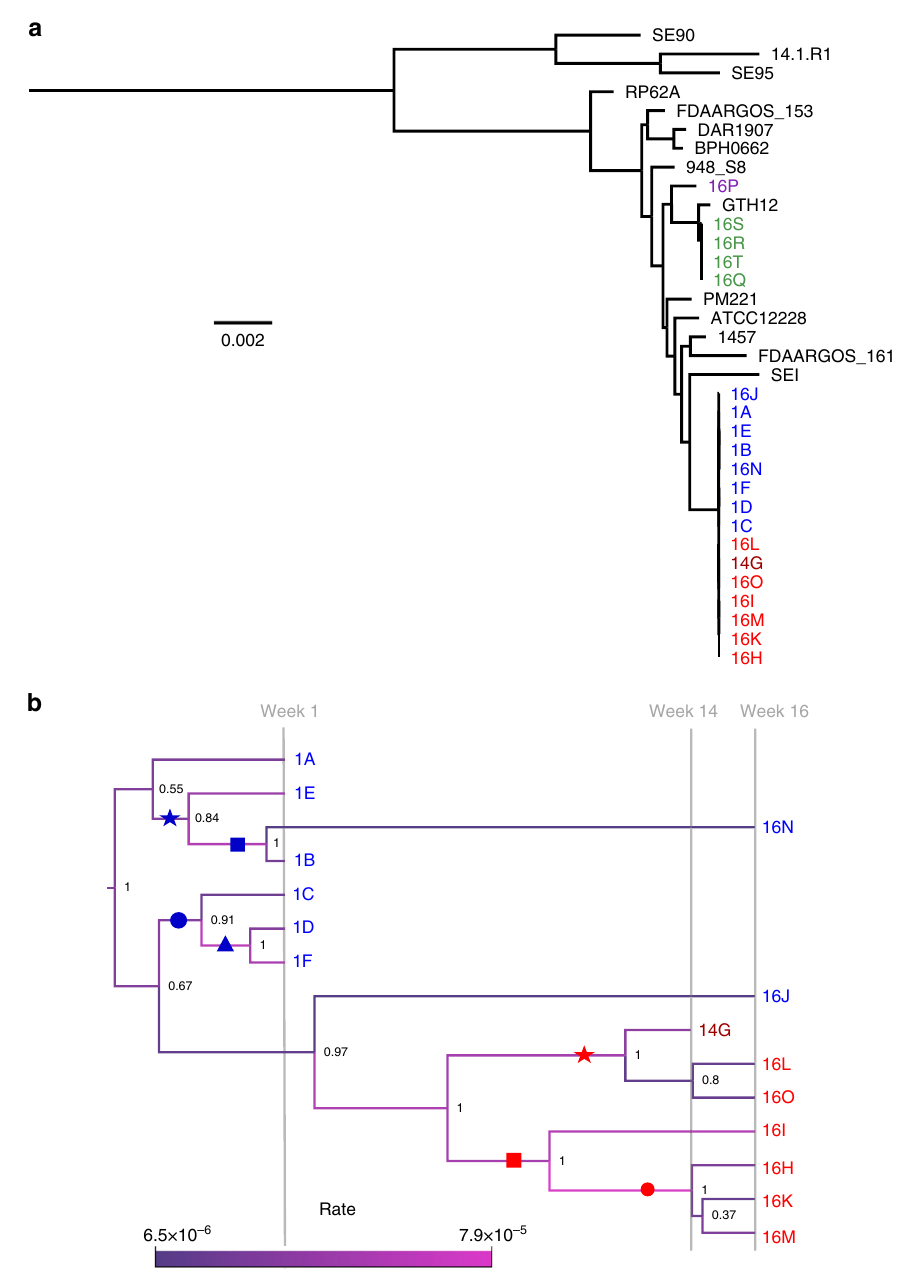
Fig. 2 Phylogenetic trees of the S. epidermidis isolates. a Midpoint-rooted maximum-likelihood tree based on the core-genes alignment of all the clinical isolates (ST59 purple, ST88 green, ST378 blue/red), and all complete S. epidermidis reference genomes available on NCBI (black, Supplementary Table 2). The scale bar indicates 0.002 SNPs per site. b Bayesian Evolutionary Analysis Sampling Trees (BEAST) phylogeny based on the ST378 isolates core gene SNPs alignment. The branch length in this tree is determined by the sampling time point. The branch coloring illustrates the estimated mutation rate (SNPs per site per year), whose range is indicated by the scale bar. Group I and group II isolates are indicated in blue and red, respectively. Dark red indicates the clinical isolate retrieved from the blood culture. The symbols (blue star, square, circle and triangle and red star, square and circle) label subclusters within the two main clusters. Denotations of these symbols can be found in the last column of Tables 2 and 3, to relate the mutations to the subcluster they